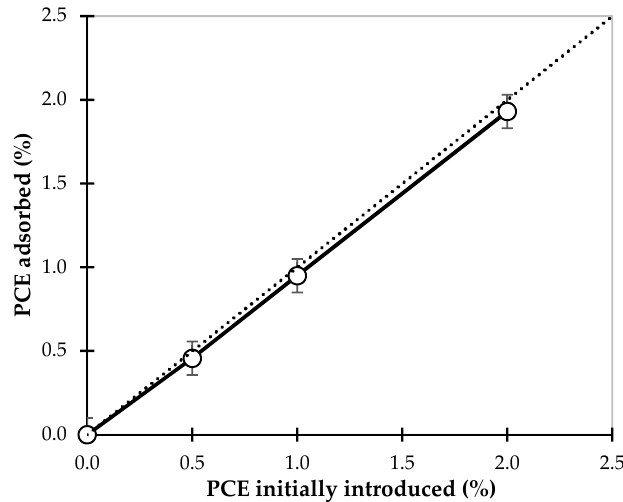
Table 3. ζ -potential values for the reference earth, the earth prepared with 2% PCE, the earth prepared with 0.2% NaHMP and the earth prepared with 0.3% NaSil .